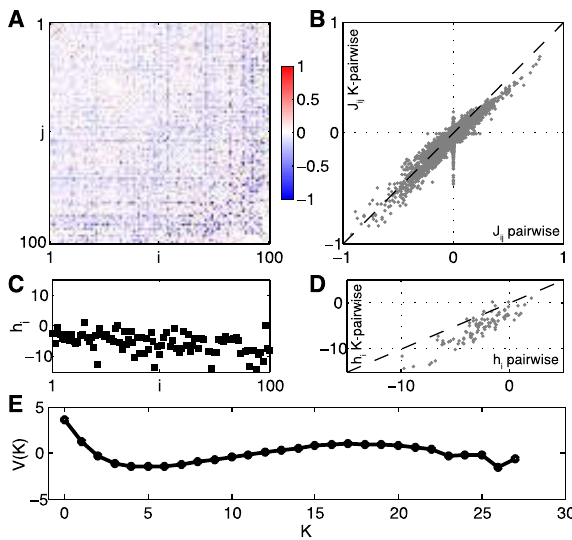
Figure 6. K-pairwise model for a the same group of N =100 cells shown in Figure 1. The neurons are again sorted in the order of decreasing firing rates. ( A ) Pairwise interactions, J ij , and the comparison with the interactions of the pairwise model, ( B ). ( C ) Single-neuron fields, h i , and the comparison with the fields of the pairwise model, ( D ). ( E ) The global potential, V ( K ), where K is the number of synchronous spikes. See Methods: Parametrization of the K-pairwise model for details.